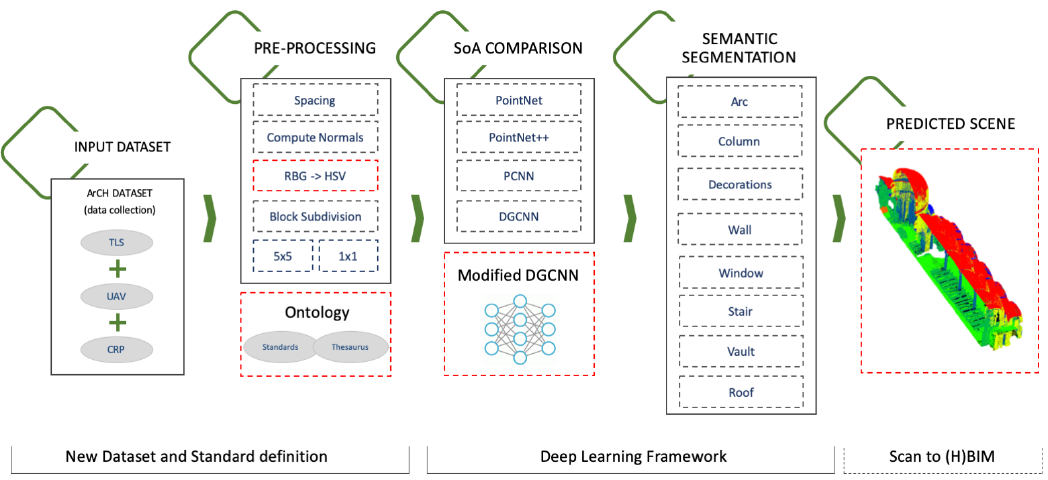
Figure 1. DL Framework for Point Cloud Semantic